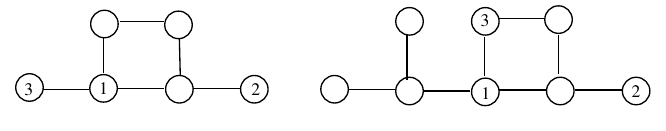
Figure 3: Two graphs G with ˜ γ ( G ) = 3 .